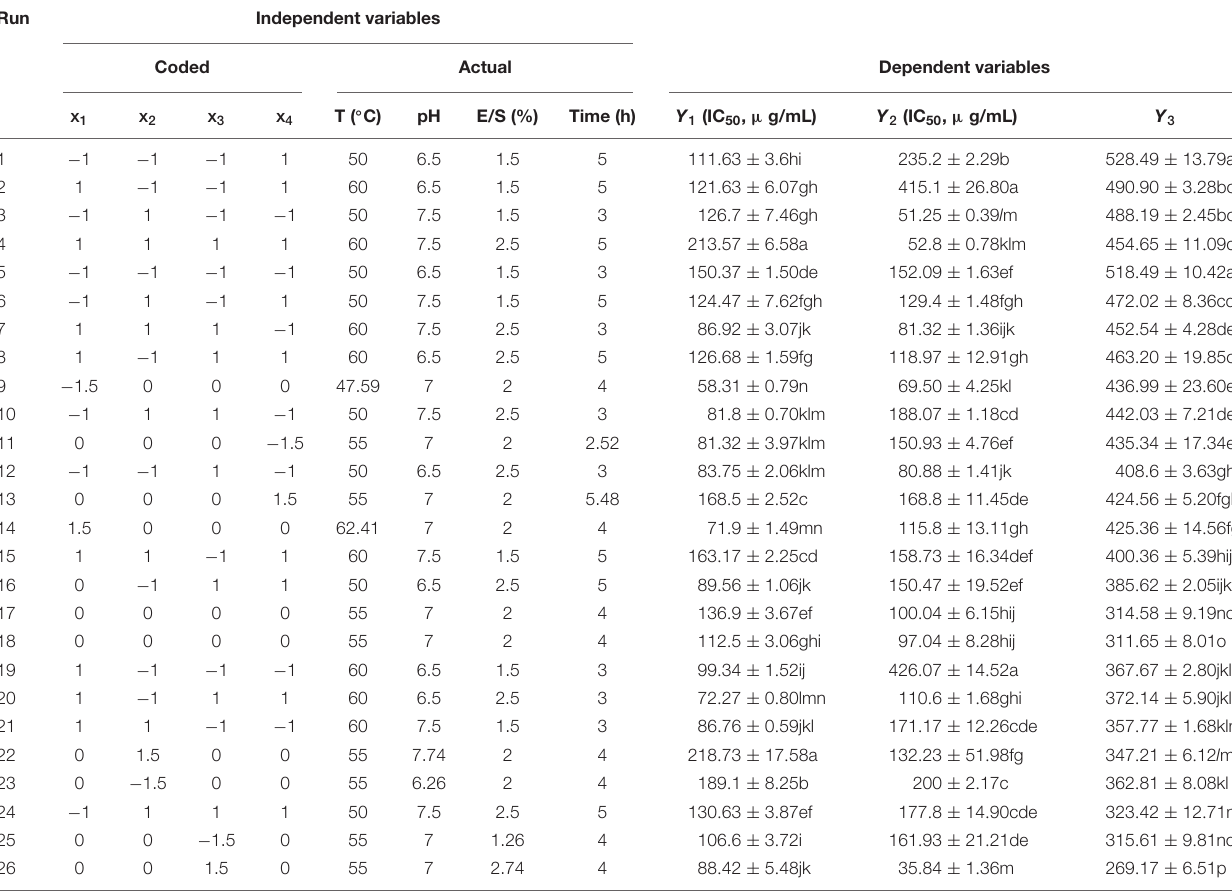
TABLE 1 | Experimental data of the antioxidant capacity for black bean protein hydrolysate treated with ficin from the central composition design. Run Independent variables Coded